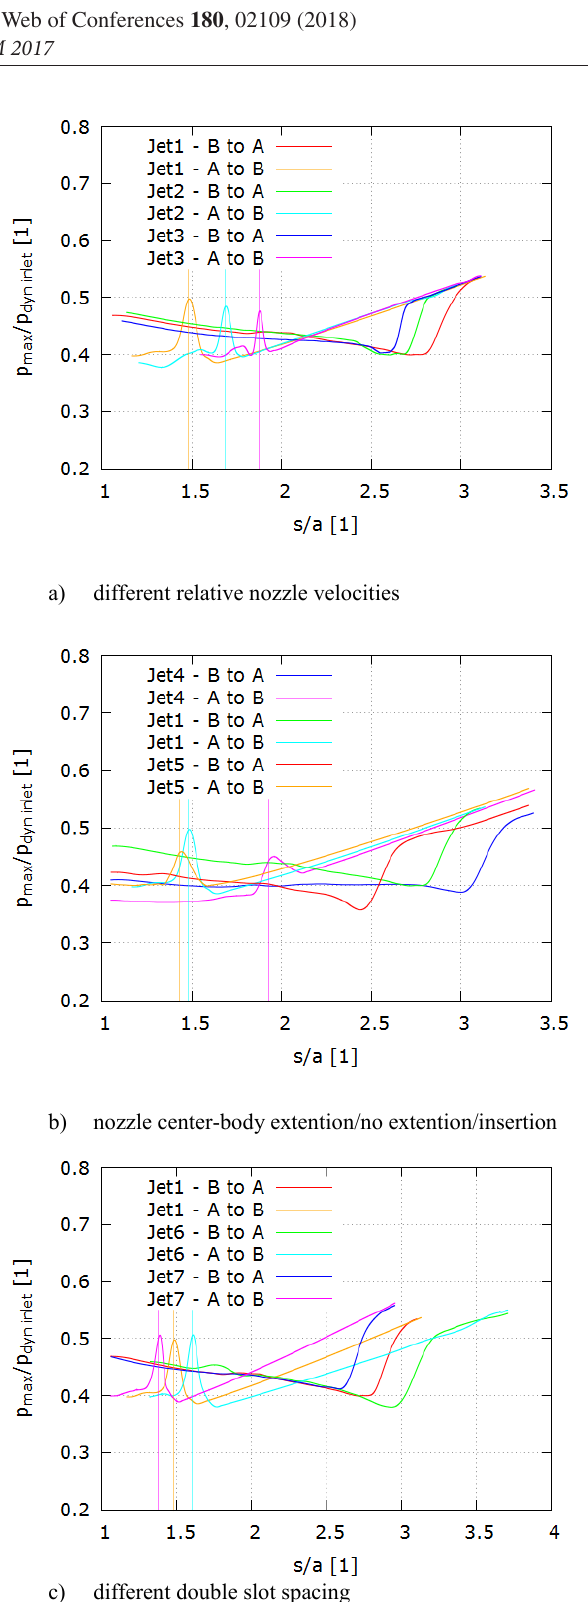
Fig. 4. Maximum stagnation